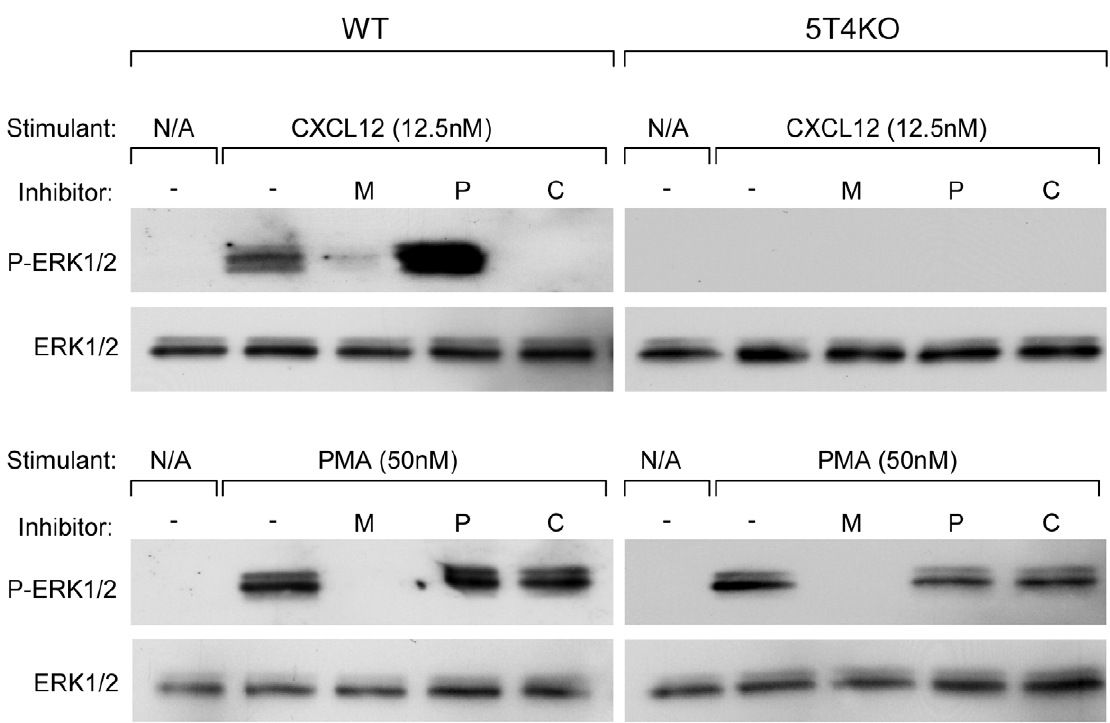
Figure 5. Disruption of cytoskeleton and CXCL12 dependent signaling in 5T4KO MEF. WT MEF exhibited an increase in ERK phosphorylation in response to CXCL12 stimulation that was prevented by the MEK1 inhibitor PD98059 (M, 50 m M) and the CXCR4 inhibitor AMD3100 (C, 10 m M) but not by the PI3K inhibitor LY294002 (P, 50 m M). 5T4KO MEF did not respond to CXCL12 stimulation, and this lack of response was specifically related to CXCR4 function and not due to a generalized disruption of MAPK/ERK signaling as both WT and KO MEF exhibited an increase in ERK1/2 phosphorylation in response to PMA stimulation, which was blocked by MEK1 inhibition but independent of both CXCR4 and PI3K activity. Total ERK was used as a loading